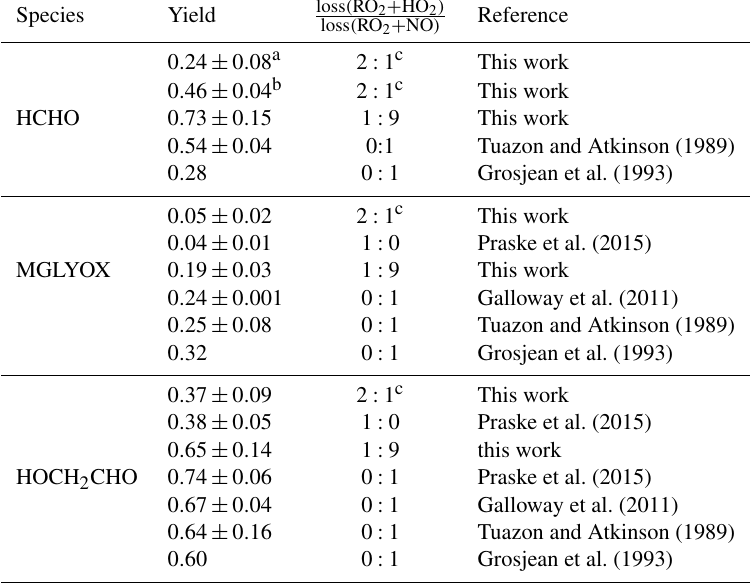
Table 3. Yields of organic products from photooxidation of MVK by OH from this work and from the literature. Errors of values from this work take into account the accuracy of measurements and precision of the calculation. HCHO is not only produced in the first oxidation step of MVK but also produced in the subsequent oxidation of glycolaldehyde and methylglyoxal. Therefore, the yield can increase over the course of the experiment. + HO 2 ) Species Yield loss ( RO 2 loss ( RO 2 + NO